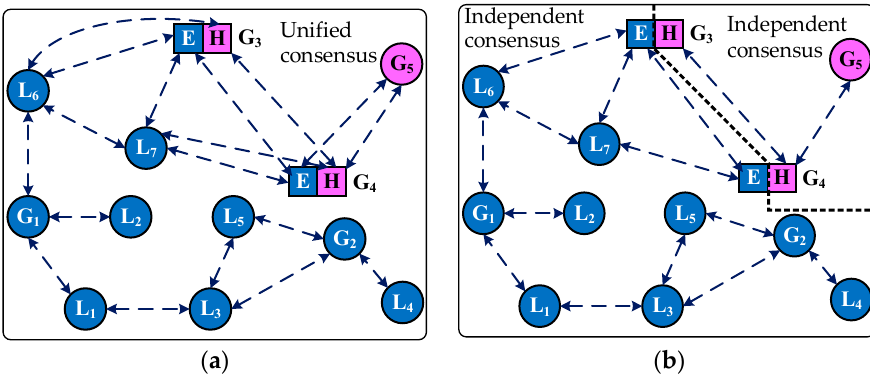
Figure 8. Interaction network of different agents. ( a ) Unified consensus; ( b ) independent consensus.